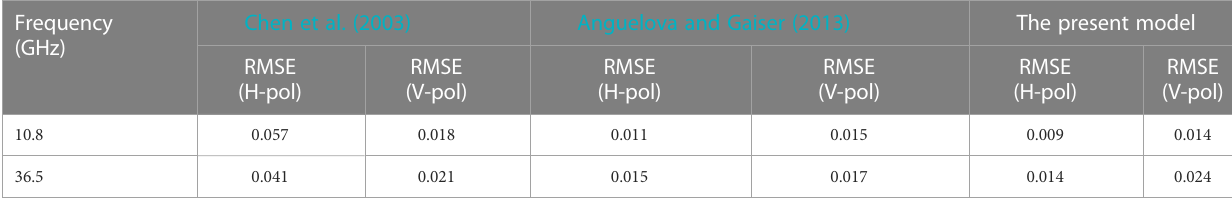
TABLE 3 RMS errors for various models compared to Rose et al. experimental data.